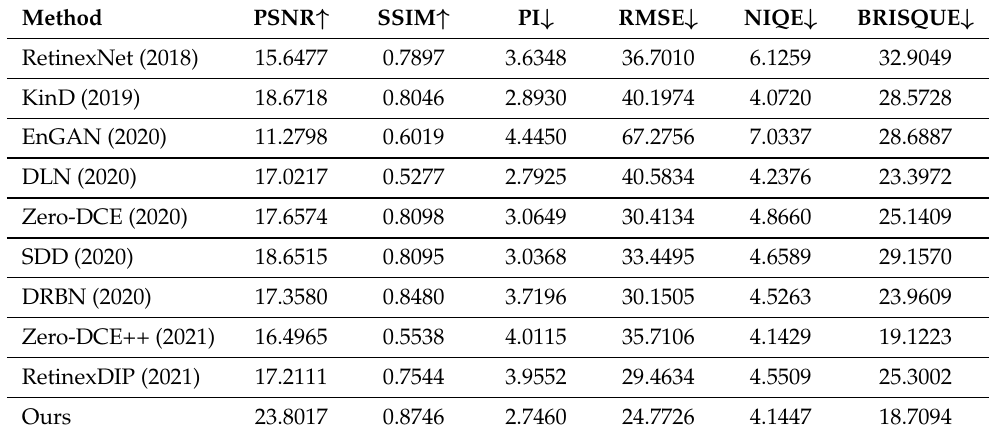
Table 3. Average performance of the different enhancement methods in Figure 7.